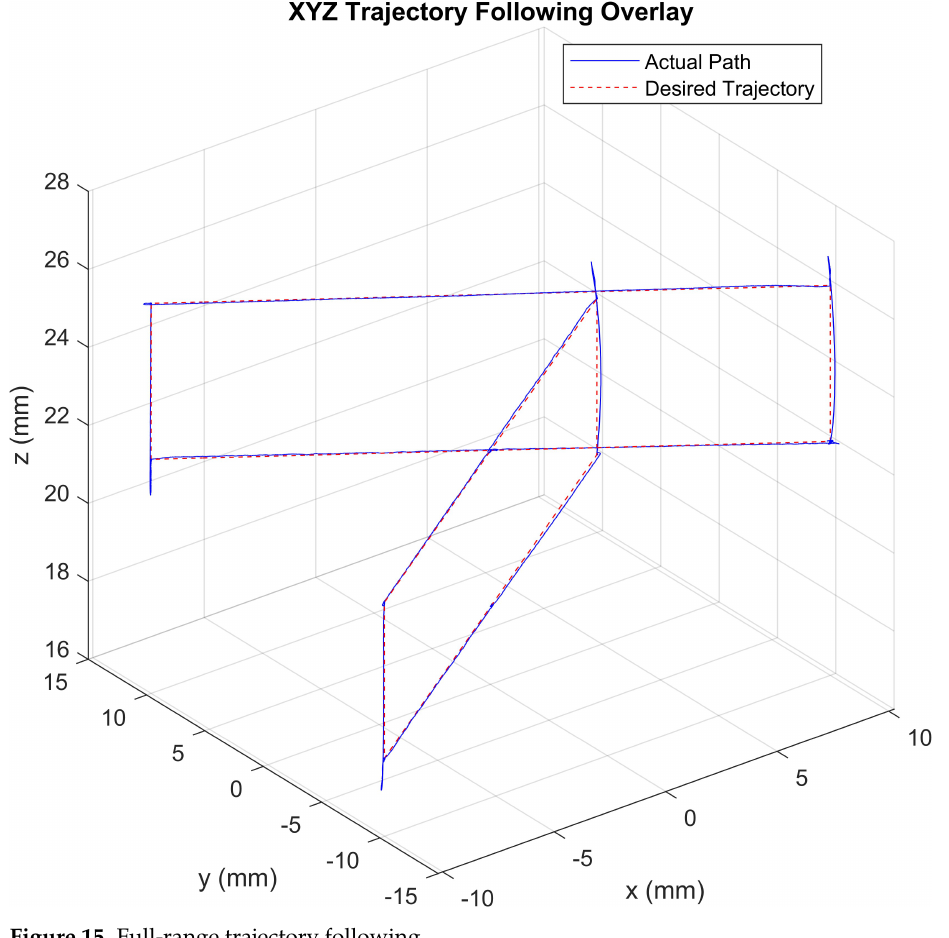
Figure 15. Full-range trajectory